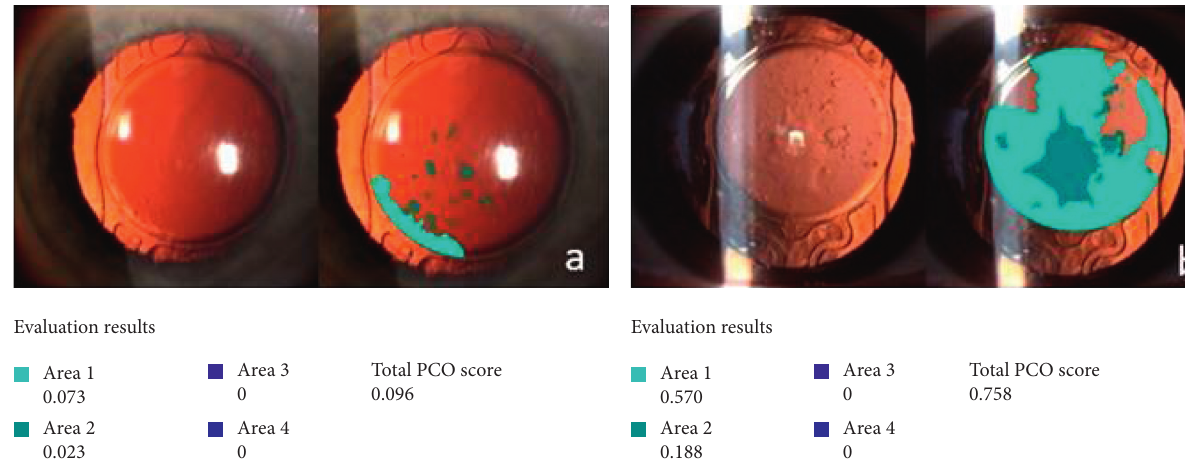
Figure 2: PCO analysis with EPCO2000 software in two study cases: (a) FLACS, patients ( n ), 41; (b) B-MICS, patients ( n ), 52. Note. Left pictures are from the slit lamp (native image), and right pictures are those from the correspondent software analysis (evaluated image). Evaluation results and legend for each single image are on the left. Table 2: CCC diameter and area, BCVA, and ECD results at baseline and 18 months for the two groups.